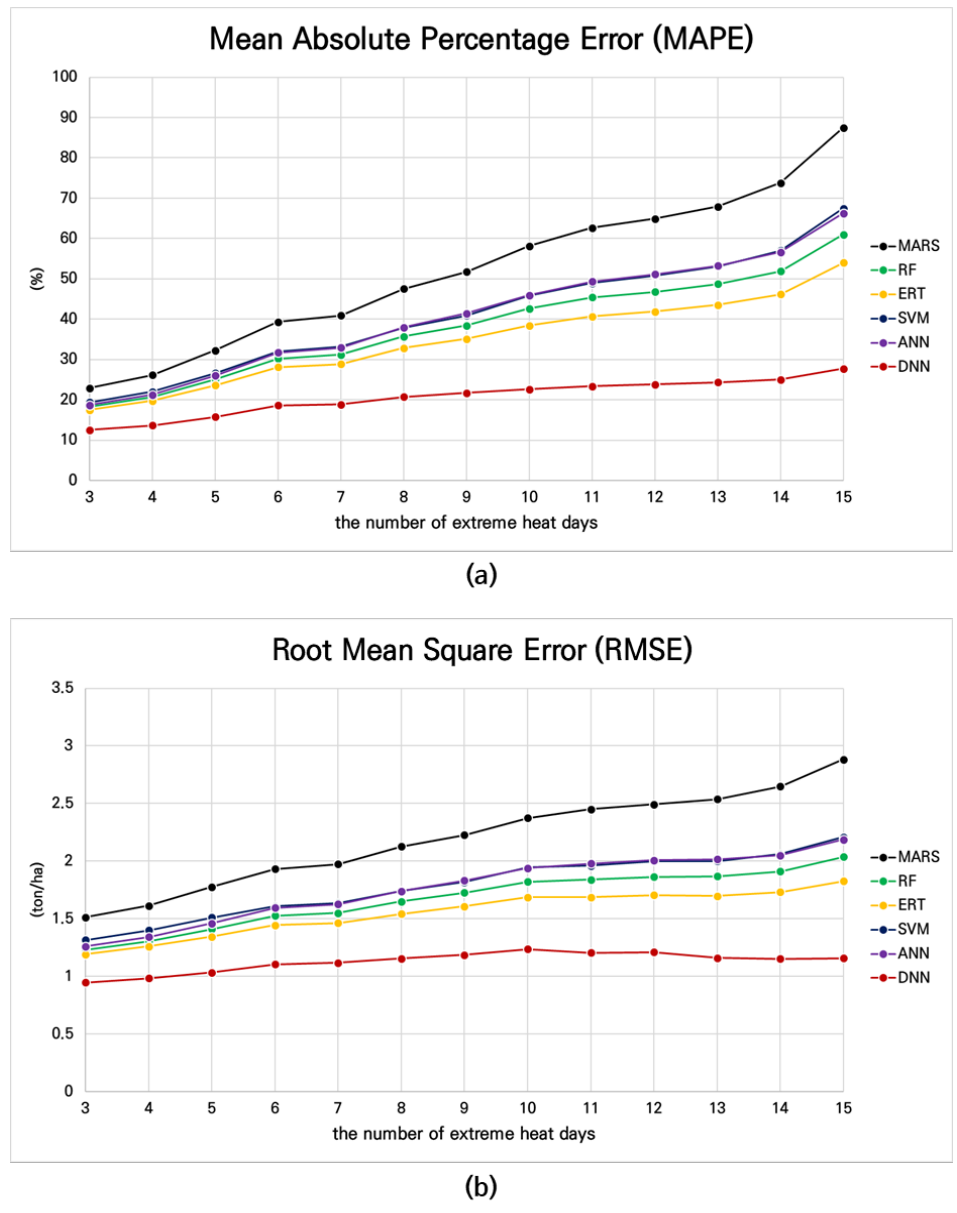
Figure 7. Validation statistics for prediction of corn yield during heatwave obtained from leave-one-year-out experiments for 2006–2015. ( a ) Mean absolute percentage error (MAPE); ( b ) Root mean square error (RMSE).